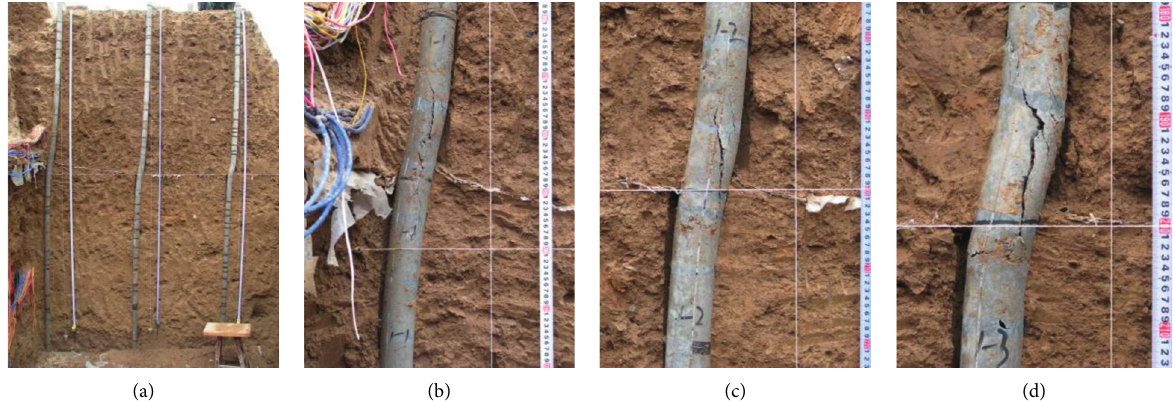
Figure 9: The damage of micropiles. (a) Overall damage of micropile groups; (b) breakage of the pile in first row near the slipping surface; (c) breakage of the pile in middle row near the slipping surface; (d) breakage of the pile in last row near the slipping surface.